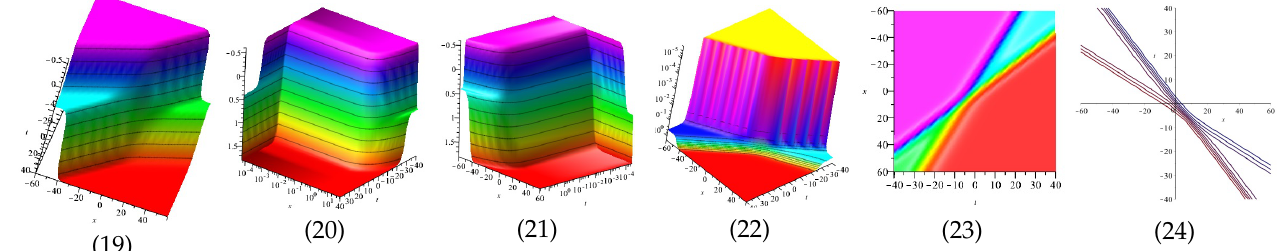
Figure 5. The 3D and 2D with the diagram of u 3,1 , in four different domains, for R 1 = 0.50, R 3 = − 0.70, S = 0.20, S = 0.70, S = − 0.30, and A = 0.80. ( 2 ) , ( 8 ) , ( 14 ) , ( 20 ) display the x − axis 2 3 1 1 orientation, ( 3 ) , ( 9 ) , ( 15 ) , ( 21 ) display the y − axis orientation, ( 4 ) , ( 10 ) , ( 16 ) , ( 22 ) , ( 5 ) , ( 11 ) , ( 17 ) , ( 23 ) display the z − axis orientation, and ( 6 ) , ( 12 ) , ( 18 ) , ( 24 ) are contour plots.